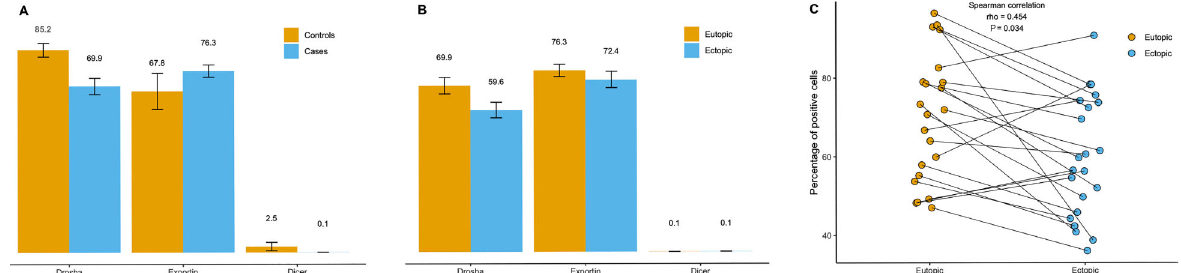
Figure 1. Expression of Drosha, Exportin, and Dicer in the endometrium of women with and without adenomyosis. A , Percentage of positive cells in eutopic endometrium from women without and with adenomyosis. B , Percentage of positive cells in eutopic and ectopic endometrium from women with adenomyosis. Data are reported as the mean and standard error. C , Correlation of the percentage of positive cells in eutopic and ectopic endometrium from women with adenomyosis.